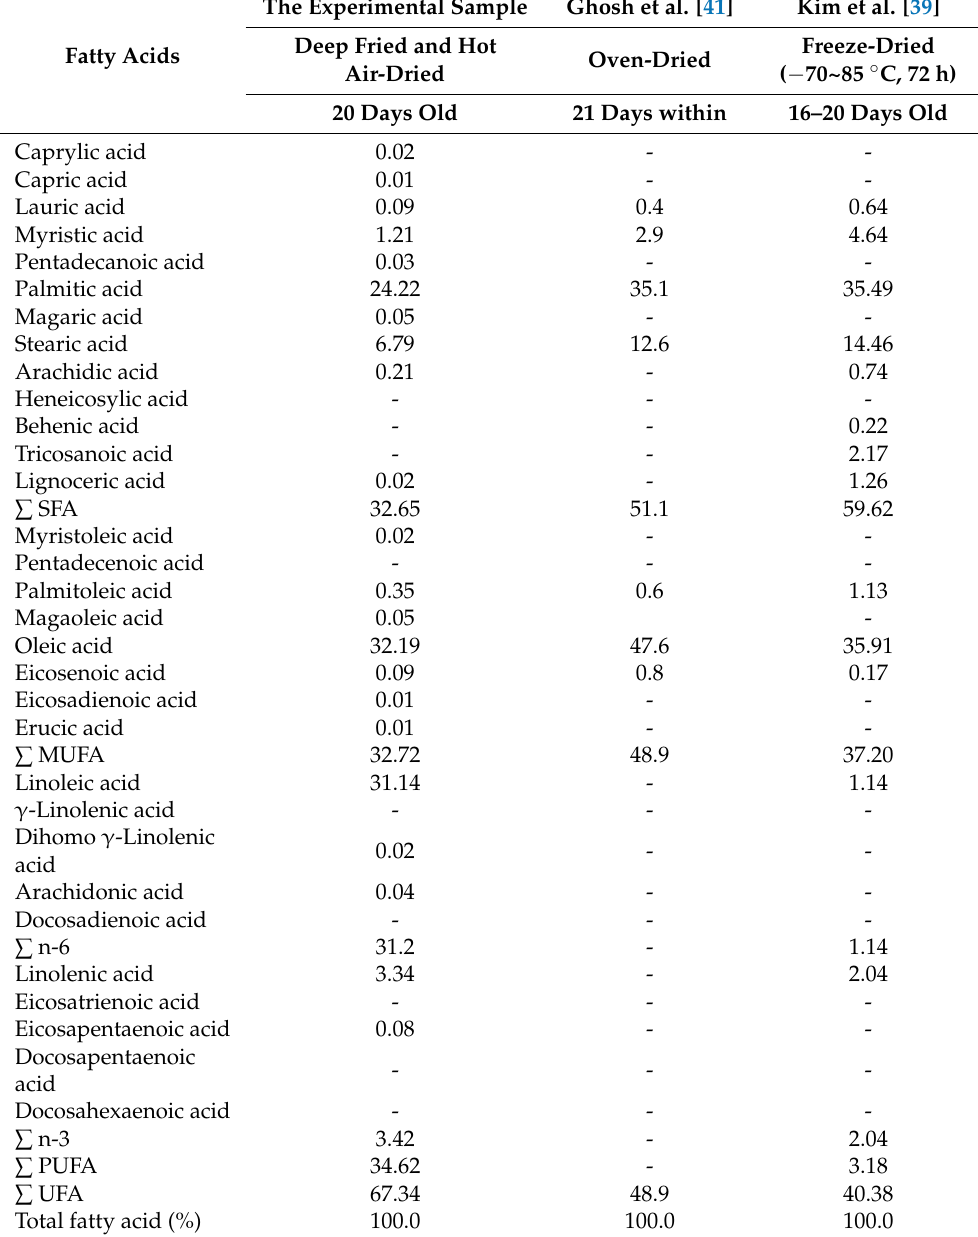
Table 8. Fatty-acid compositions of the optimal drone pupae powder and other references for bee powder (% of total fatty